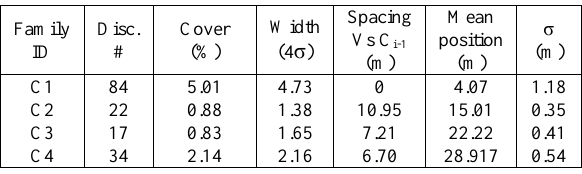
Table 10. DiscontinuityLab results for the Saulges F2 family Family ID